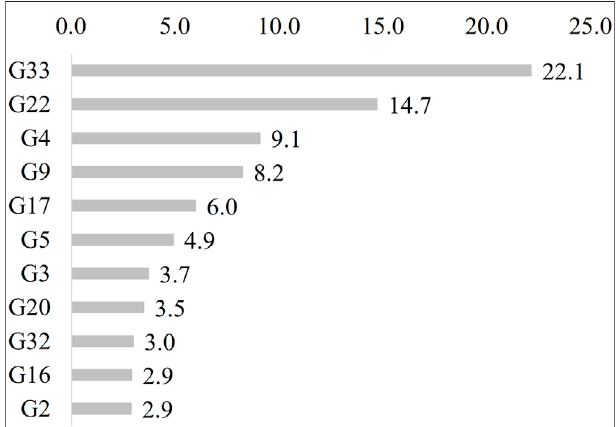
FIGURE 7 | Most cited ailment categories (G33 is Wounds etc., G22 is Hemorrhoidsetc.,G4isAntibacterialetc.,G9isBoilsetc.,G17isEczema,G5 isAnti-in fl ammatory,G20isExcrescencesetc.,G3isAntibleedingetc.,G32is General skin ailments, and G16 is Dog bites etc.).